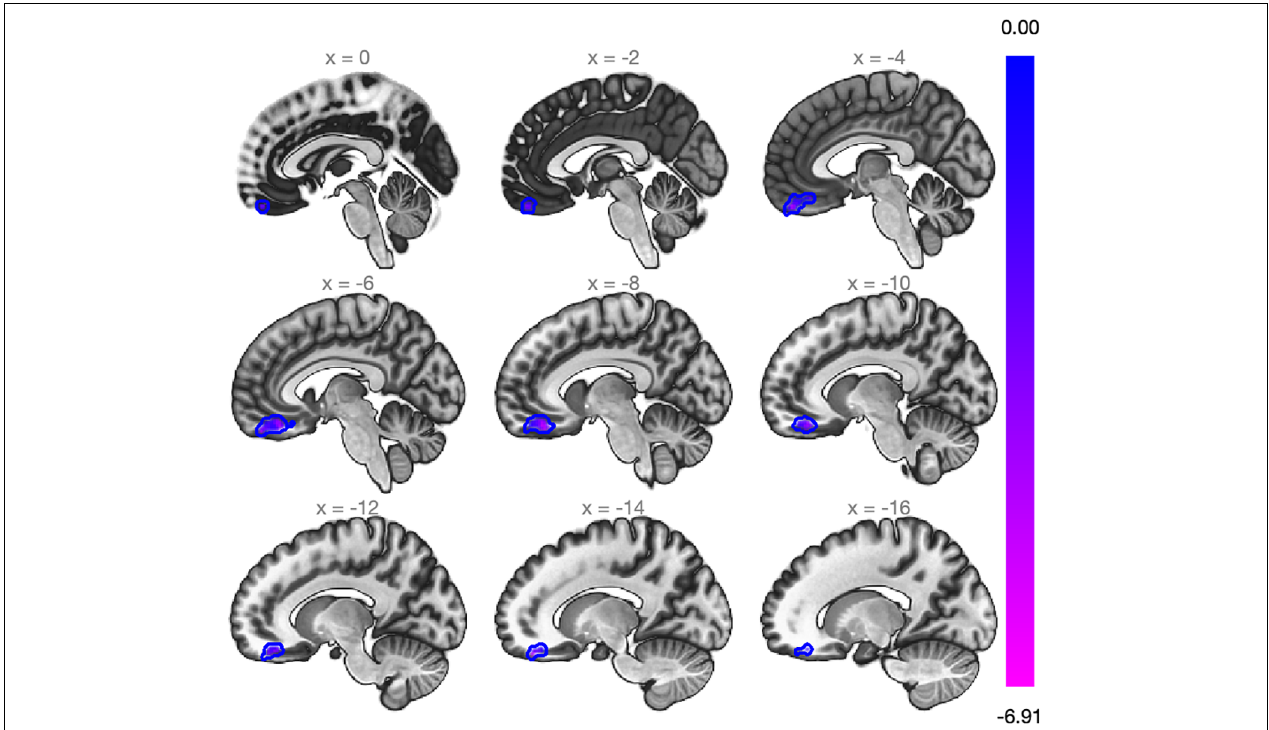
FIGURE 3 | Whole-brain analysis using data-driven seed originated with the MVPA. Slicing view of the cluster within the medial frontal cortex that exhibited a decrease in the rs-FC (beta = –0.27; Cluster size p-FDR = 0.0013). The blue bar on the right decodes statistical significance.